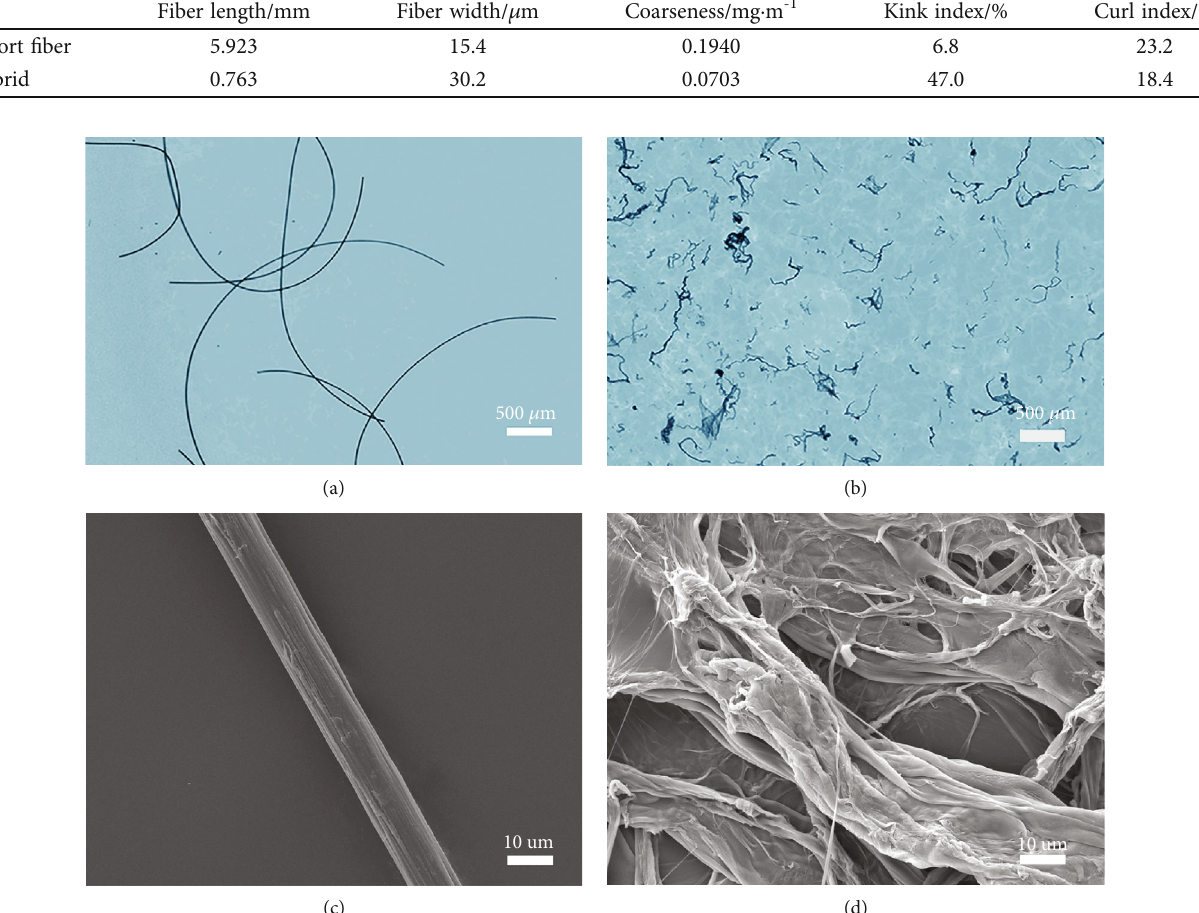
Figure 1: Microscopic images of meta-aramid fi ber: (a) short fi ber; (b) fi brid and SEM images from surface: (c) short fi ber and (d) fi